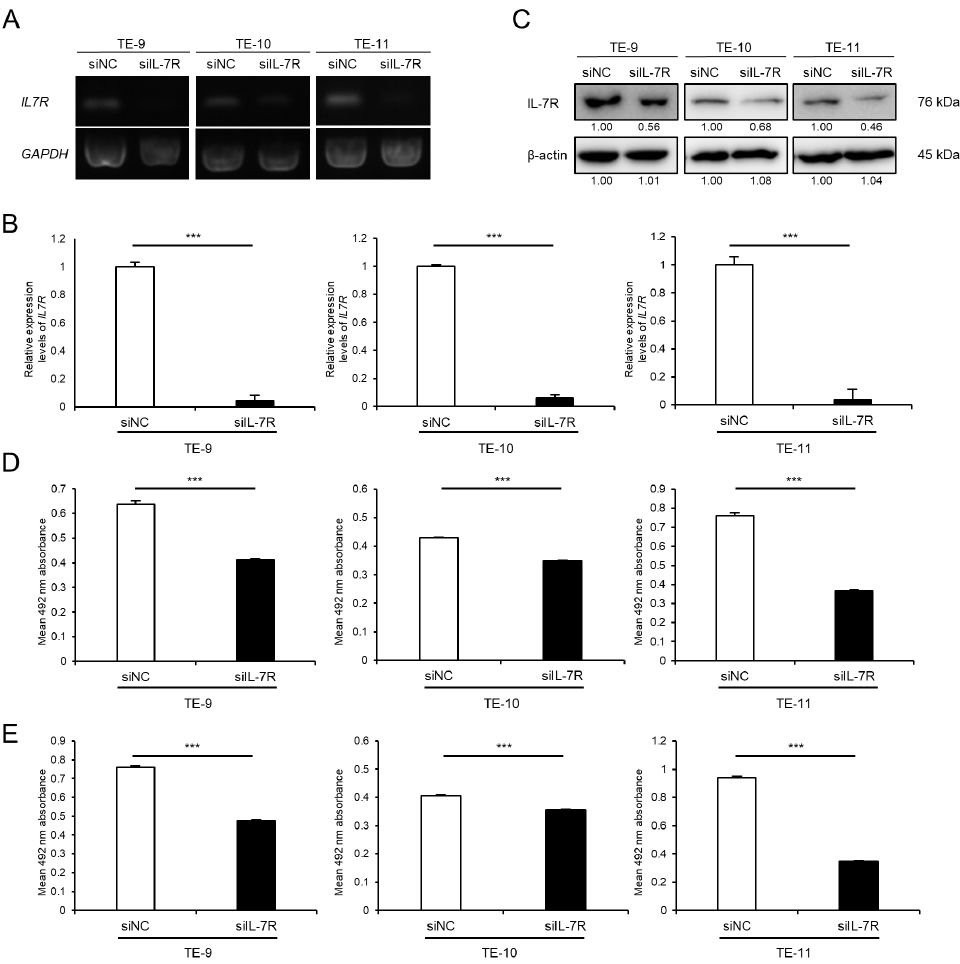
Figure 3. Knockdown of IL-7R suppresses the survival and growth of ESCC cells. ( A , B ) The expression levels of IL7R mRNA in TE-9, -10, and -11 cells transfected with 20 nM siRNA against IL-7R (siIL-7R) or negative control siRNA (siNC) were confirmed by RT-PCR ( A ) and qRT-PCR ( B ). GAPDH was used as an internal control. ( C ) The expression levels of IL-7R protein in TE-9, -10, and -11 cells transfected with siIL-7R or siNC, were confirmed by Western blot analyses. β -actin was used as an internal control. The expression level was normalized using ImageJ software; the relative value was set to 1.00 for siNC-transfected cells. ( D , E ) Cell proliferation assays were conducted to investigate the effect of IL-7R knockdown on the survival ( D ) and growth ( E ) of ESCC cells. Data are presented as the mean ± SEM. *** p < 0.001.